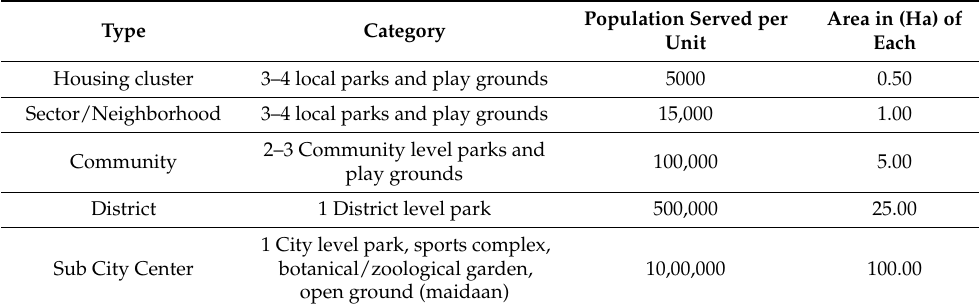
Table 6. Open and Green Space Distribution.